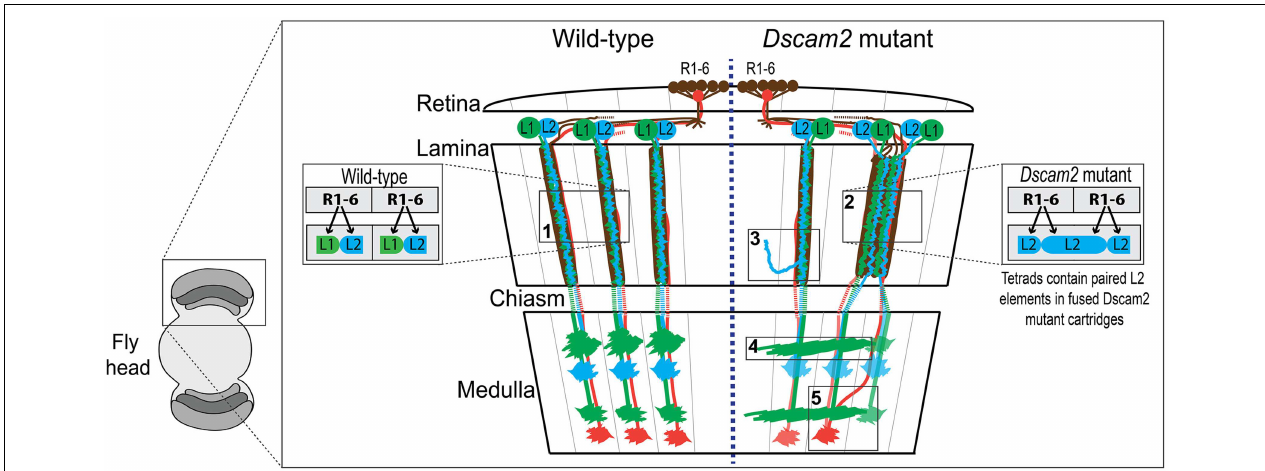
FIGURE 1 | Wiring diagram of the optic lobes of wild type and the Dscam2 mutant. Schematic of wild type (WT) (left-side) and Dscam2 mutant (right-side) optic lobes with wiring details highlighted in boxes. Photoreceptors R1-6 (brown) in the retina form synapses with a postsynaptic complex that includes L1 (green) and L2 (blue) lamina neurons. Photoreceptors R7 (red) and R8 (not-shown) project directly to the medulla. (1) In WT animals, L1 and L2 are postsynaptic at every photoreceptor